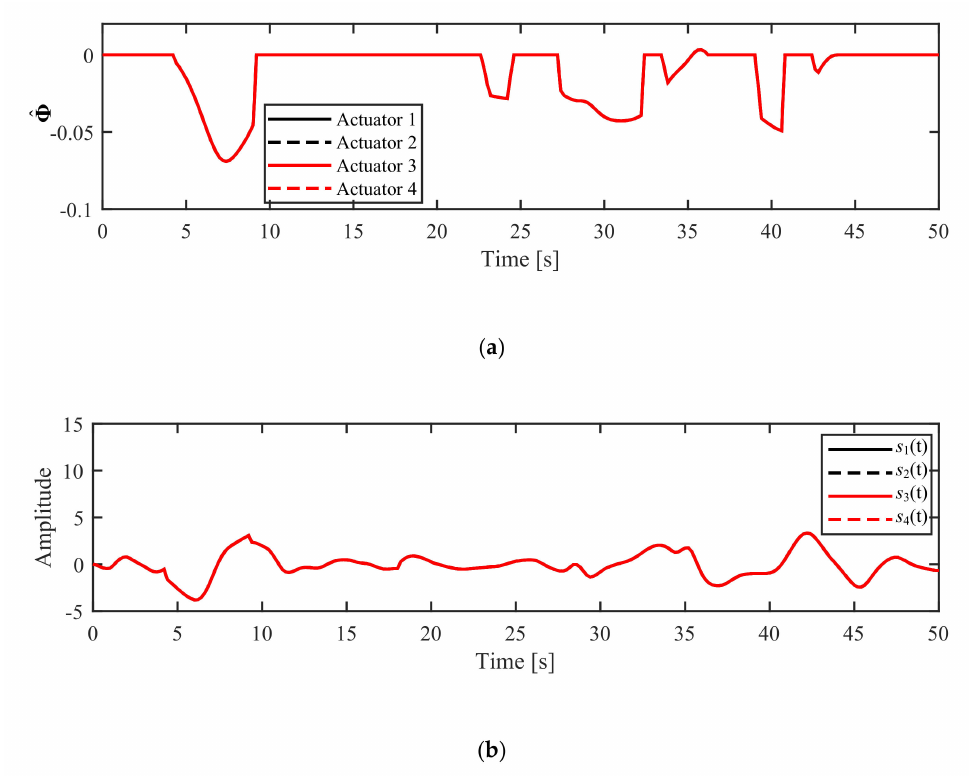
Figure 22. The performance of the proposed controller in NM mode: ( a ) Updating switching gains of the ASTSMC-TDE (ASMC term); ( b ) Sliding manifold variables.